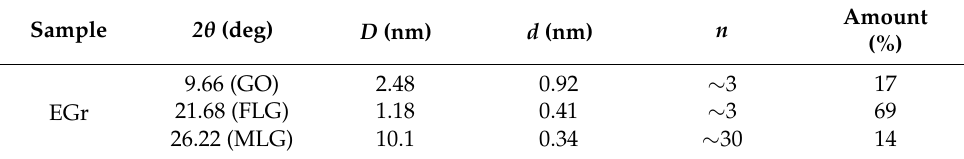
Table 1. Structural parameters obtained from the corresponding XRD pattern: graphene crystallite size ( D ), interlayer distance (d ), average number of layers ( n ), and their amount ( % ) within the graphene sample .